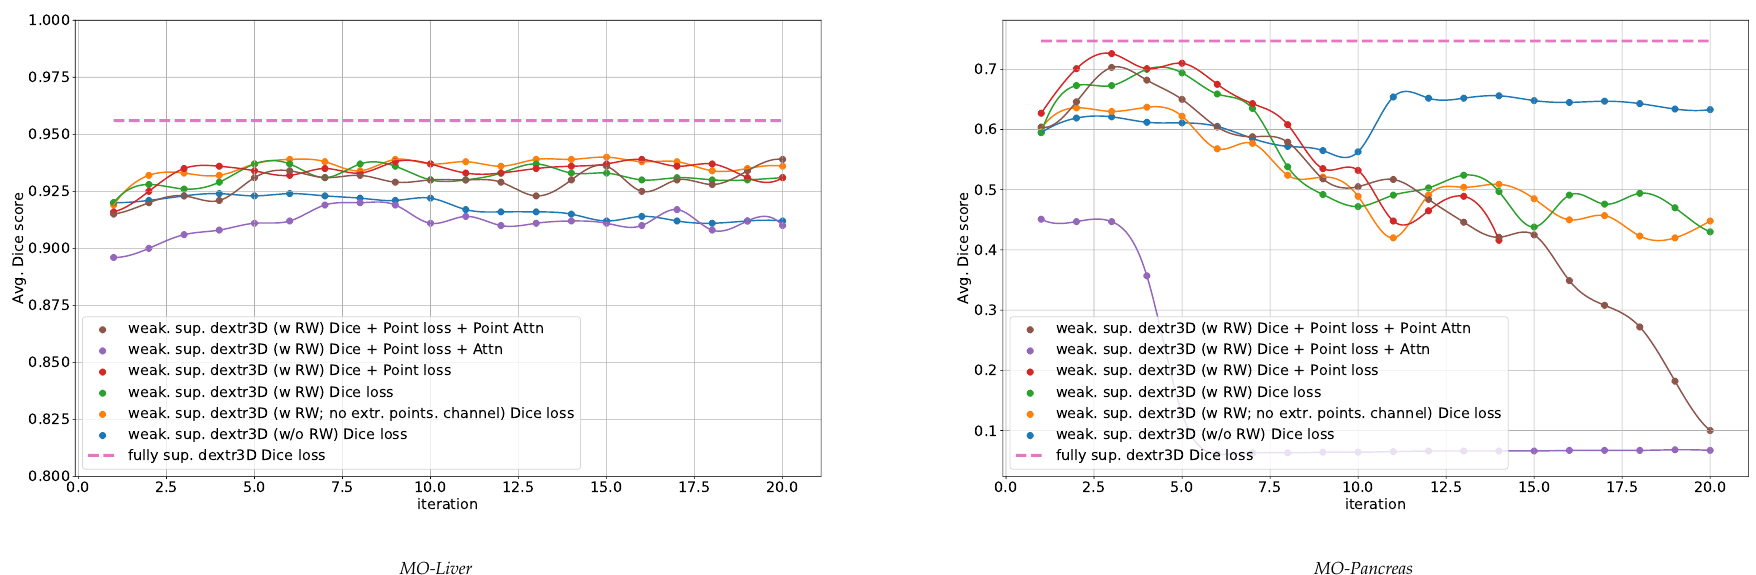
Figure 5. Weakly supervised training from random walker initialization. For illustration, we only show the MO-Liver and MO-Pancreas segmentation tasks with the varying training settings as shown in our ablation study of Table 1 at each round of deep network training. Although the performance of the MO-Liver models generally improves with the number of iterations, it can also be noticed that for MO-Pancreas , a poor initialization by the random walker can cause the models to degrade quickly. Notice that adding the point channel information results in a more stable training